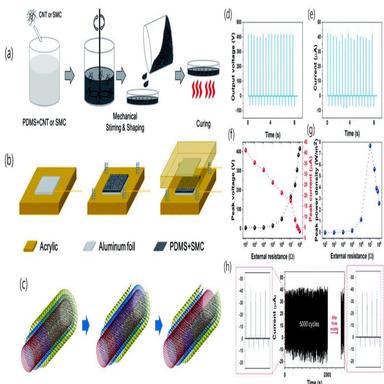
(a) Schematic diagram of the process for fabricating CNTs or SMC-PDMS and (b) the triboelectric nanogenerator (TENG). (c) Schematic illustration of the transformation from CNT to SMC. (d) Output voltage of the optimized SMC-PDMS and (e) Current curve of the SMC-PDMS based TENG. (f) Peak output voltage, current and (g) power density under different external resistances. (h) Stability and durability test of the SMC-PDMS based TENG for 5000 cycles, and measurement results after three months (right red-dashed b